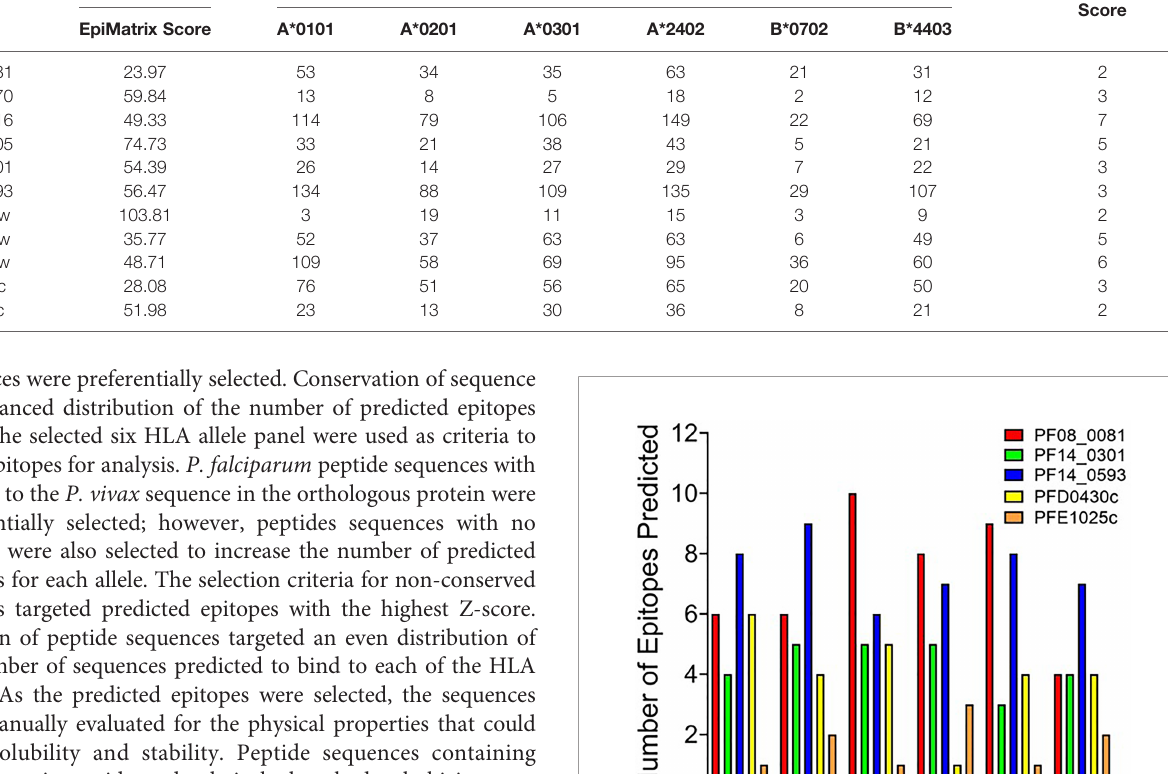
TABLE 2 | Number of class I epitopes for each of six selected class I HLA supertype alleles in each of the eleven selected proteins. Protein